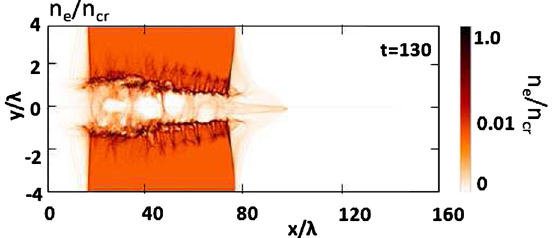
FIG. 2. The distribution of He 4 ion density in the course of a 1 PW laser pulse interaction with a 60 λ NCD He 4 target at t ¼ 130 × 2 π = ω .